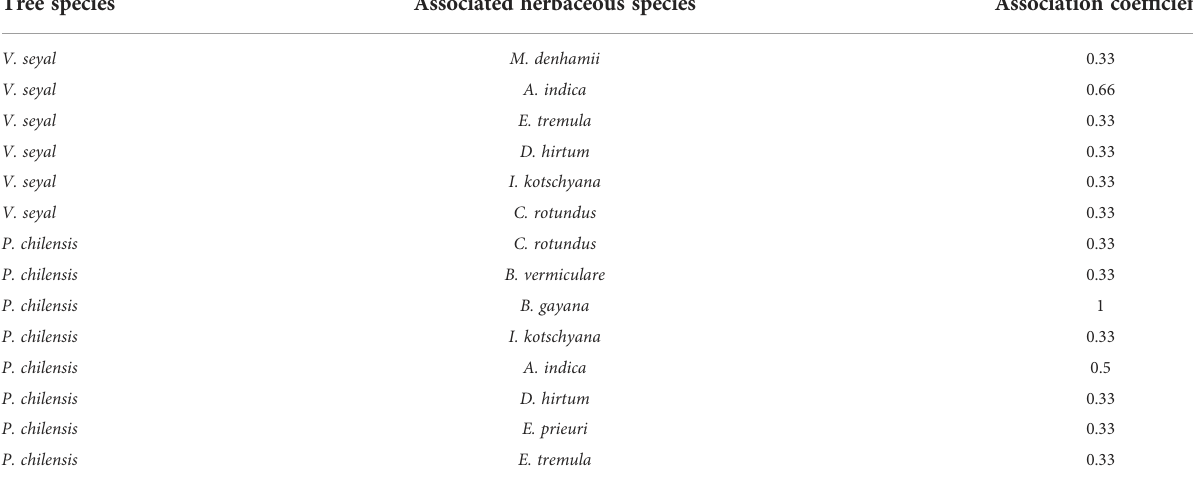
TABLE 3 Association coef fi cient of Vachellia seyal and of Prosopis chilensis vs. herbaceous species. Tree species